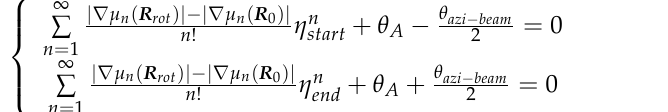
Figure 10. Schematic of the synthetic aperture of CF-SAR.